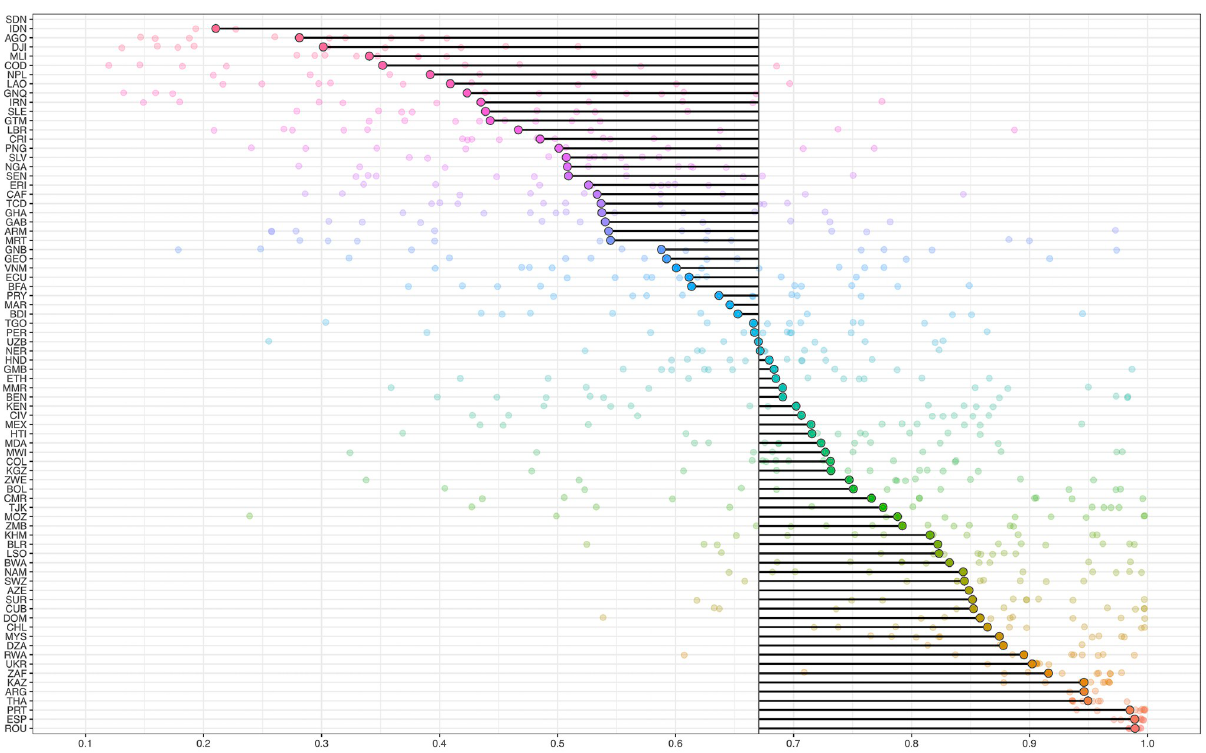
Fig 6. Average bias-corrected efficiency scores by country (N = 78). Notes : Average technical efficiency across country-years is depicted by the middle vertical line. Dots present each observation per country. Y-axis shows country codes. SDN has below 0.1 values (see Table C of Section B in S1 Text for further details on scores estimated per